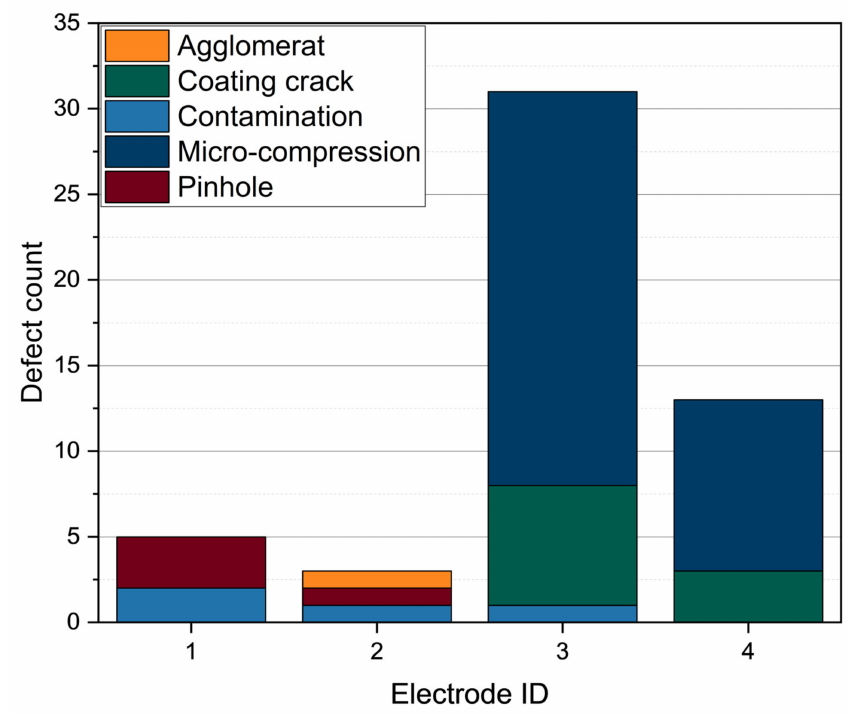
Figure 7. Assignment of certain defect to the respective electrode